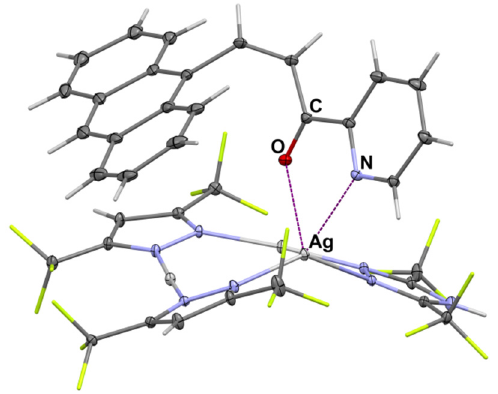
Figure 3. XRD structure of complex Z -1Ag with thermal ellipsoids set at the 15% probability level. Hydrogen and Fluorine atoms are sticks for clarity.